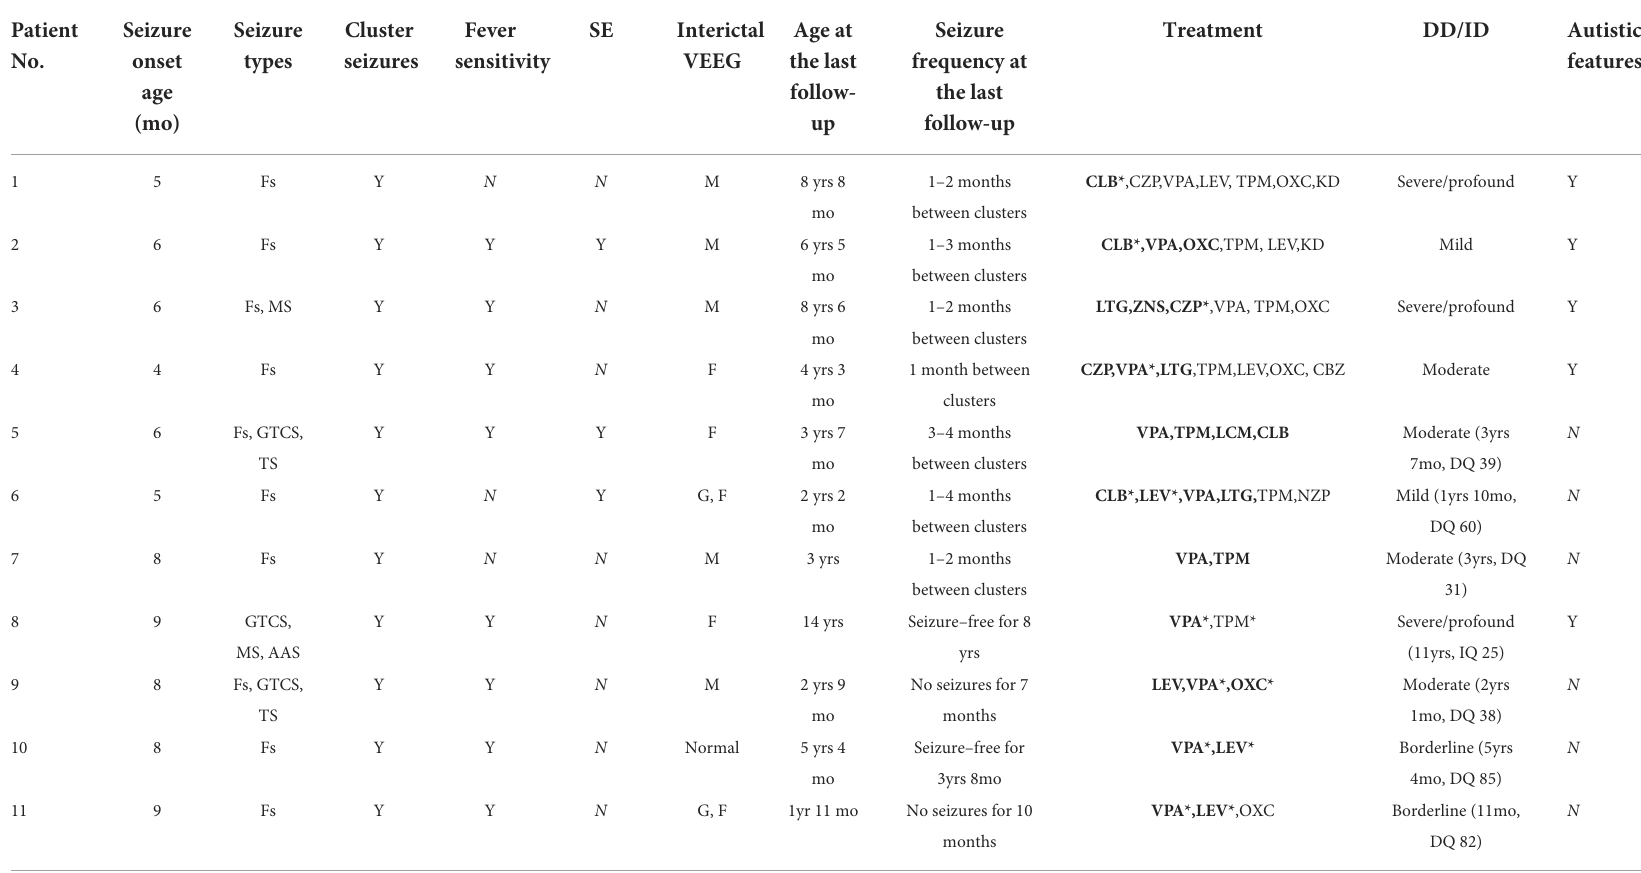
TABLE 2 Clinical features of 11 mosaic male patients with PCDH19 -related epilepsy in our cohort.